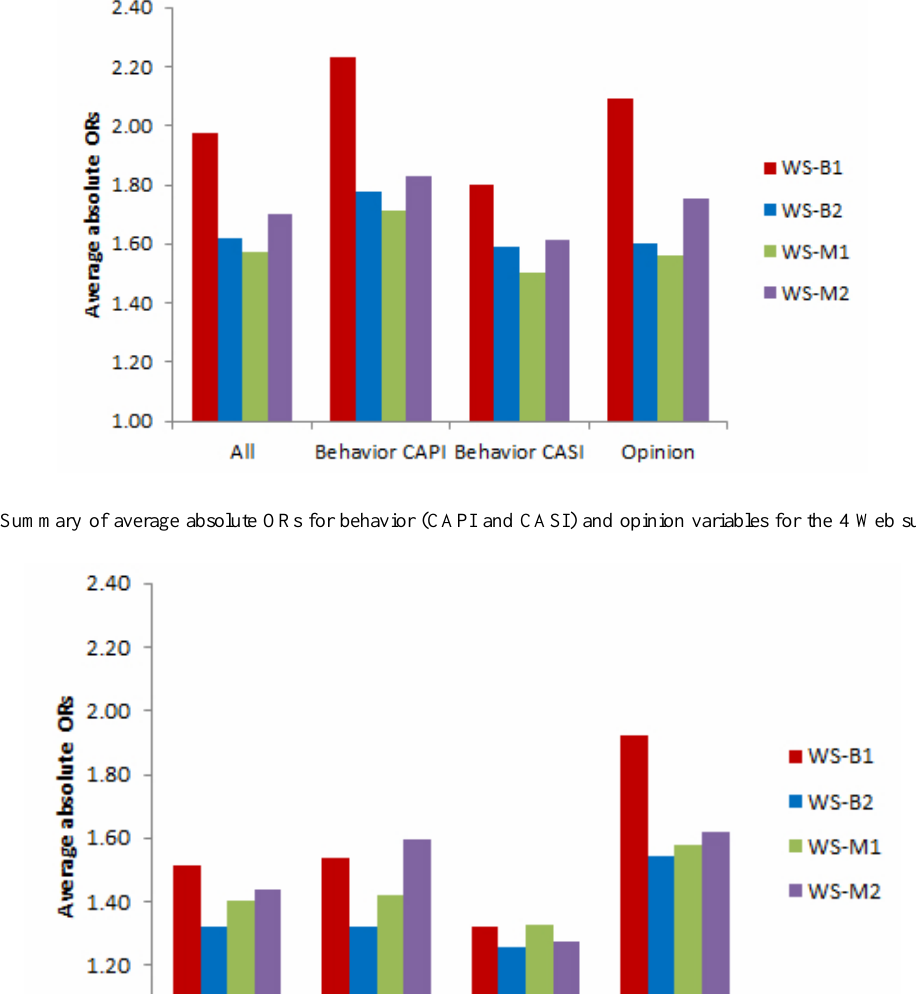
Figure 2. Men: Summary of average absolute ORs for behavior (CAPI and CASI) and opinion variables for the 4 Web surveys compared with Natsal-3.